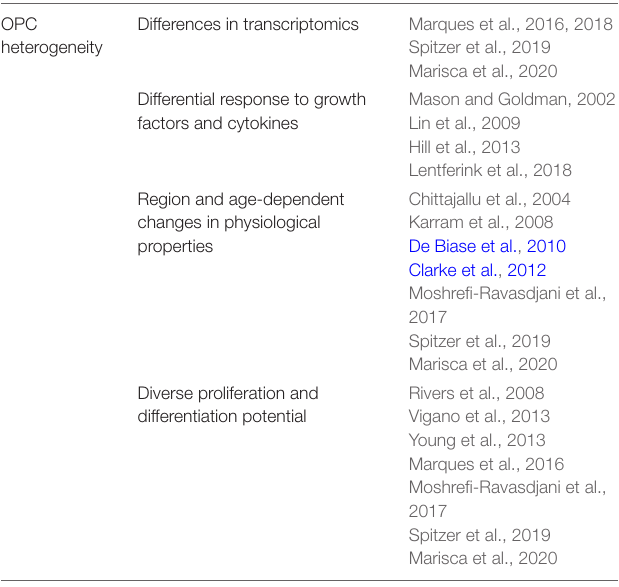
TABLE 2 | Reviewed literature on OPC